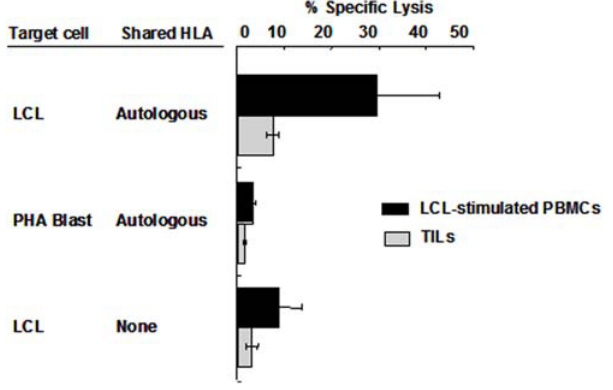
Figure 7. Cytotoxic activity of LCL-stimulated cultures and TILs from NPC patients. The mean 6 SD percentage lysis at 10:1 E:T ratio of LCL- stimulated cultures (n=15) and TILs (n=9) from NPC patients is shown in the